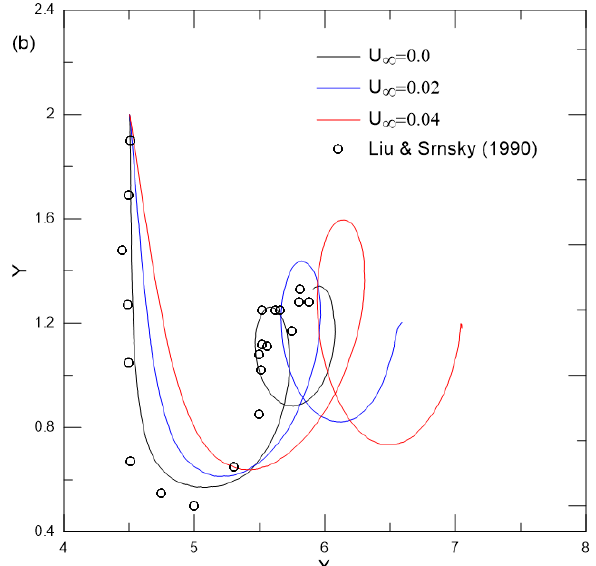
Figure 13. Influence of combined effects of buoyancy forces and crosswind on predicted trajectories of the vortical structures from wing tips (Ri = 2.036, T ∞ * = 20 ◦ C, T W * = 60 ◦ C, Pr = 0.7, and Re = 7650): ( a ) left side and ( b ) right side [9].